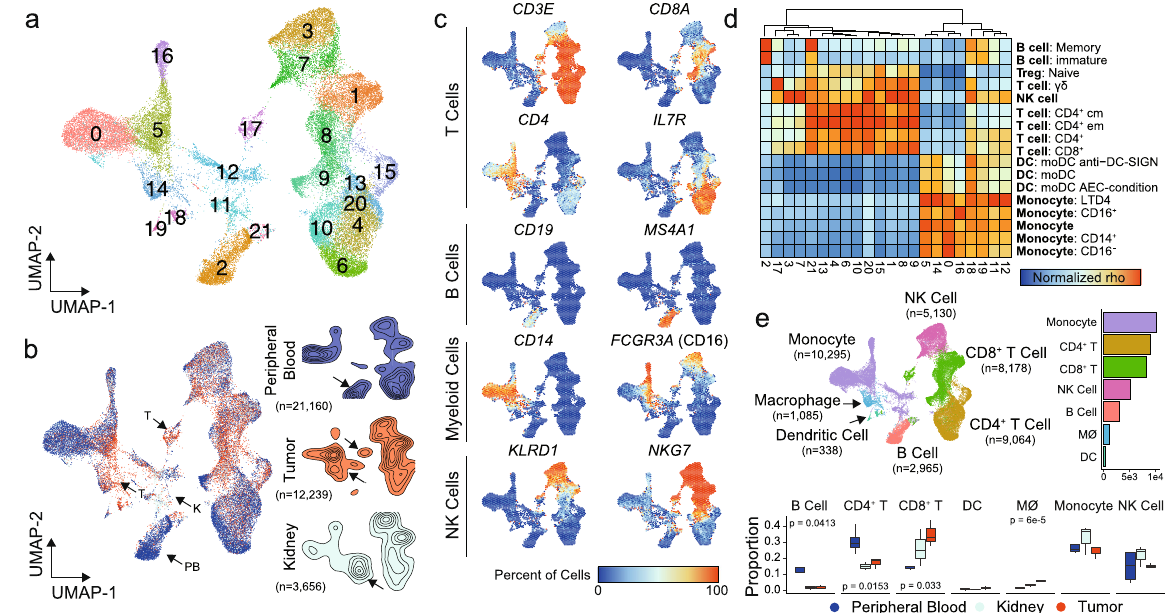
Fig. 1 Single-cell RNA sequencing results from immune cells in ccRCC. a UMAP of 37,055 primary immune cells of peripheral blood, normal renal parenchyma and tumor-in fi ltrating ccRCC patients. b Distribution of cells by tissue type, peripheral blood (blue), tumor (red), and kidney (light blue). Arrows indicated potential enriched or unique immune cells populations for tissue type. c Percent of cells expressing canonical immune cell markers across the UMAP. d Normalized correlation values for predicted immune cell phenotypes based on the SingleR R package for each cluster; dendrogram based on Euclidean distance. e UMAP demonstrating inferred immune cell types in ccRCC, clusters are colored by cell type and proportion of single-cell per sequencing run by tissue type. P values based on one-way ANOVA; lack of labeled p values equates to value